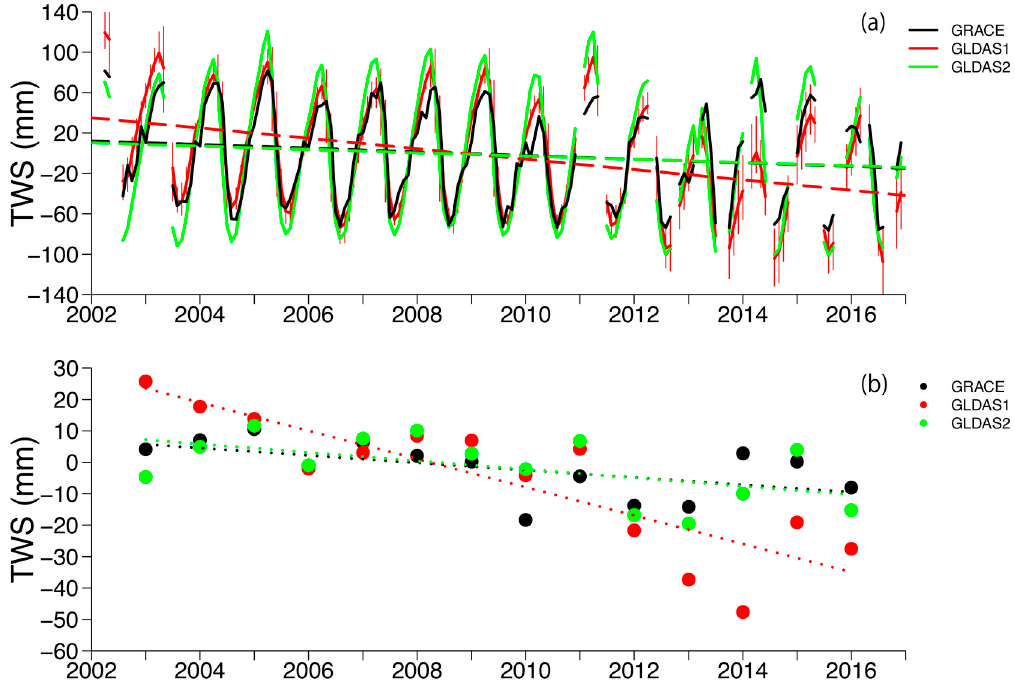
Figure 2. ( a ) Monthly and ( b ) annual temporal variations in TWS anomalies in the Arctic circumpolar tundra region from 2002 to 2016. Long dashed and dotted lines denote the linear trend lines for the monthly and annual values, respectively. Vertical red lines denote the maximum and minimum range of GLDAS1-based TWS.